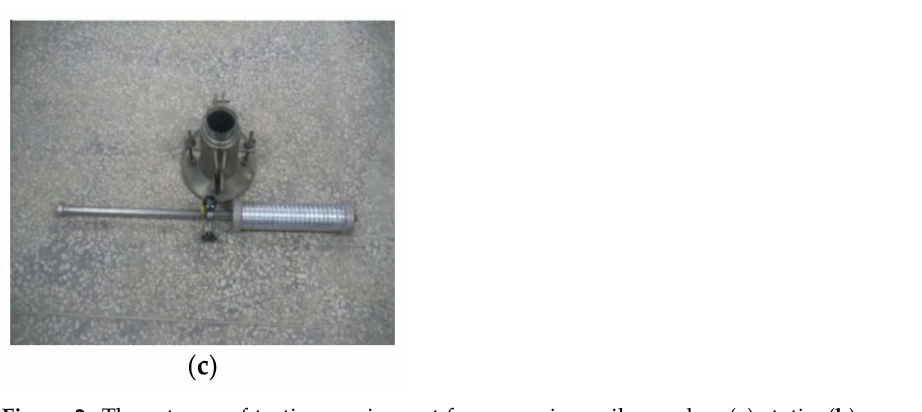
Figure 2. Three types of testing equipment for preparing soil samples: ( a ) static; ( b ) compaction; ( c ) kneading.